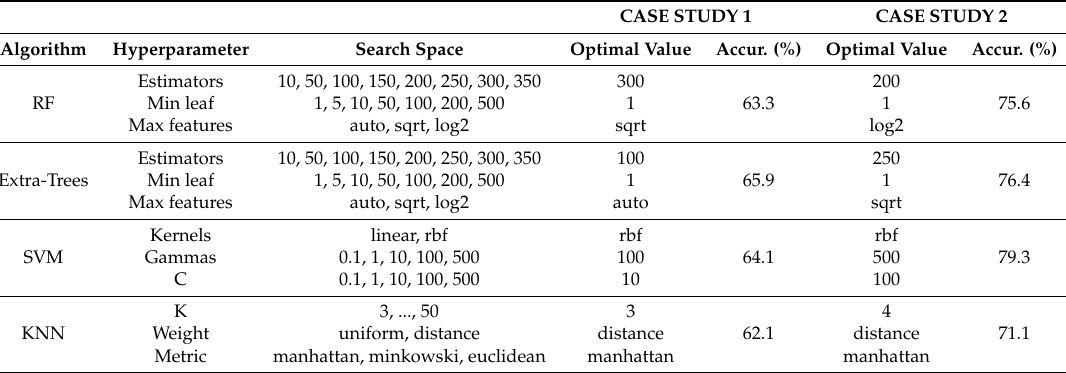
Table 5. Comparison of ML algorithms including weather